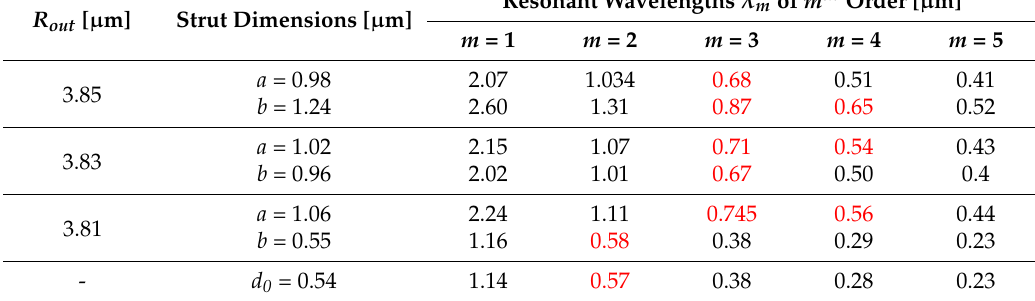
R out [ µ m] Strut Dimensions [ µ